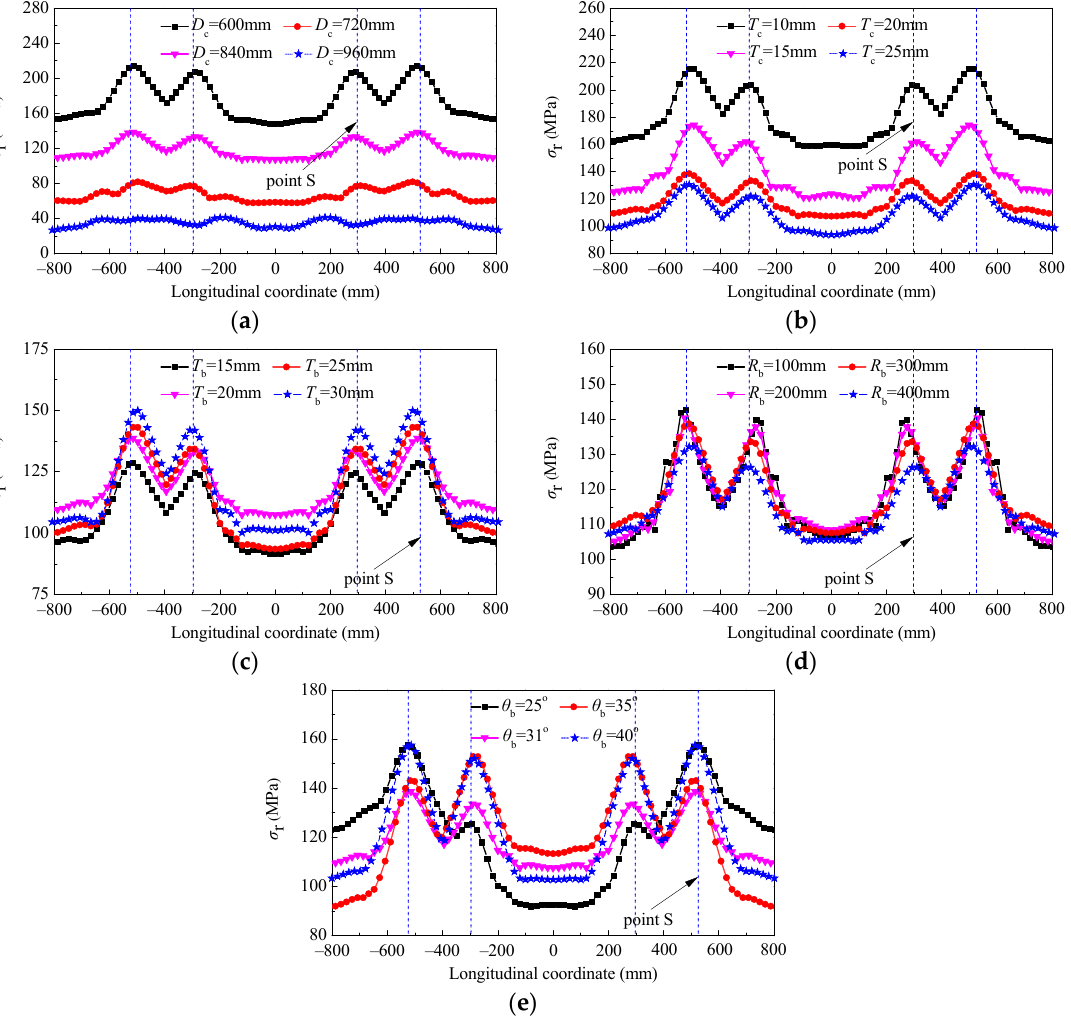
Figure 13. Sensitivity of hot spot stress distribution to parameters: ( a ) D c ; ( b ) T c ; ( c ) T b ; ( d ) R b ; and ( e ) θ